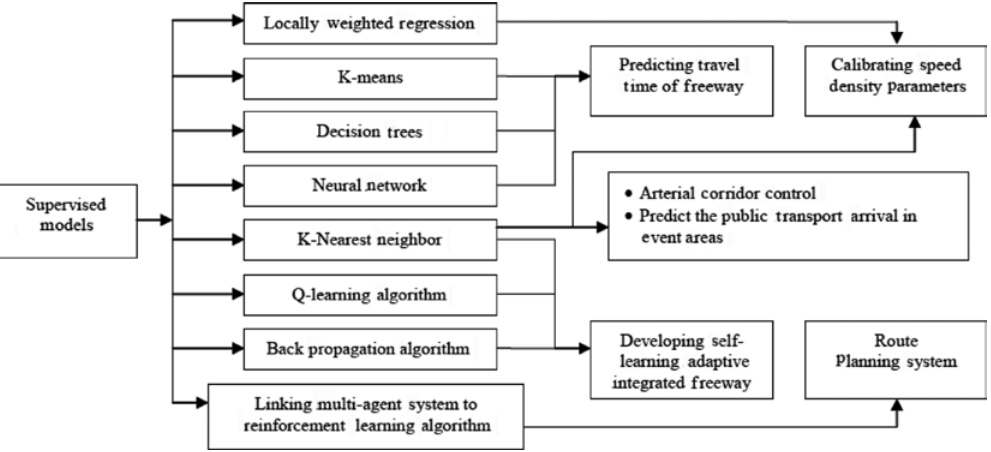
Figure 3: List of Supervised Models Used in Intelligent Transportation